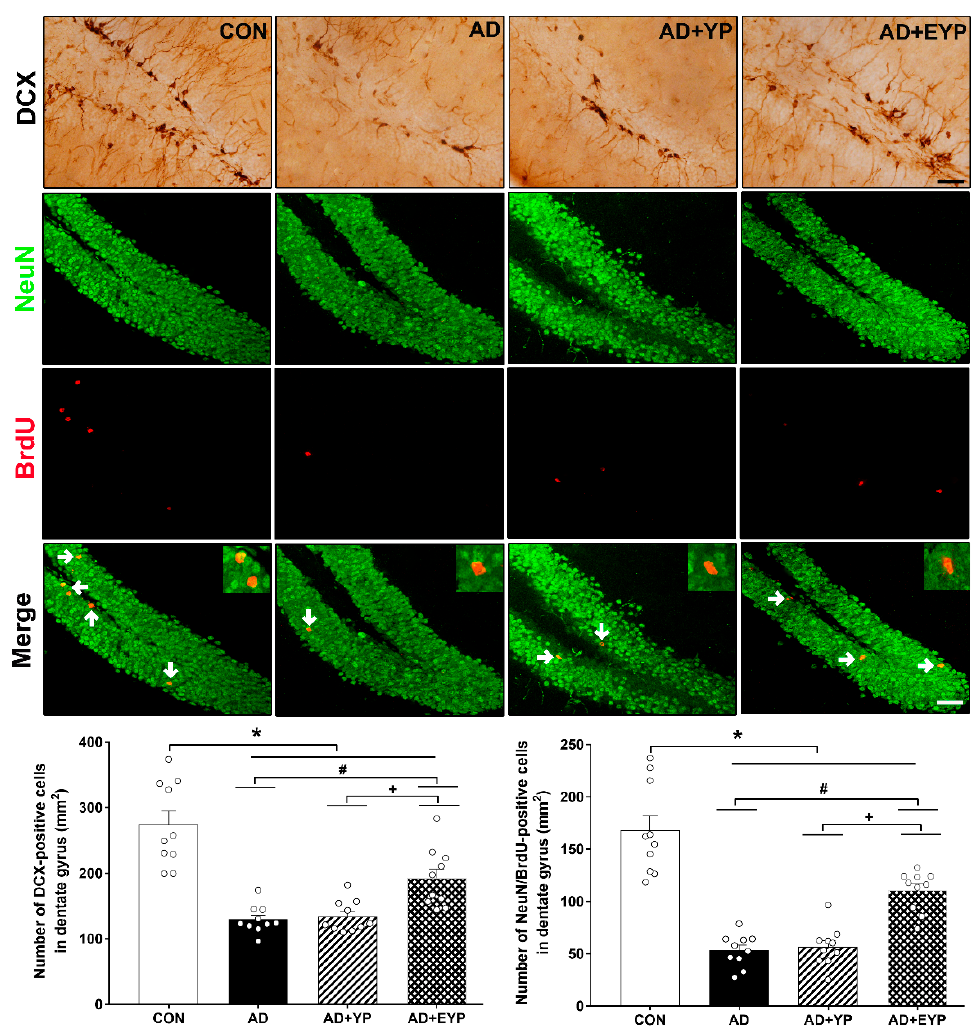
Figure 8. E ff ect of plasma from young exercised mice on cell proliferation and neurogenesis in the hippocampus. CON: wild-type, AD: 3xTg-AD, AD + YP: 3xTg-AD and Young plasma injection, AD + EYP: 3xTg-AD and exercised young plasma injection group. Photomicrographs and data of DCX- and NeuN / BrdU-positive cells (white arrows). The scale bar represents 50 µ m. Data are expressed as the mean ± standard error of the mean (SEM). *, p < 0.05 compared to the CON group. #, p < 0.05 compared to the AD group. + , p < 0.05 between AD + YP and AD + EYP groups.